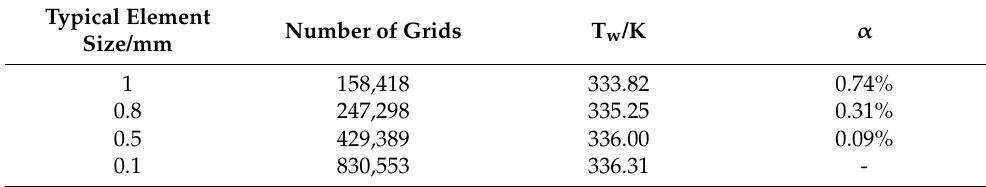
Table 2. The relation between temperature with typical element size and number of grids.